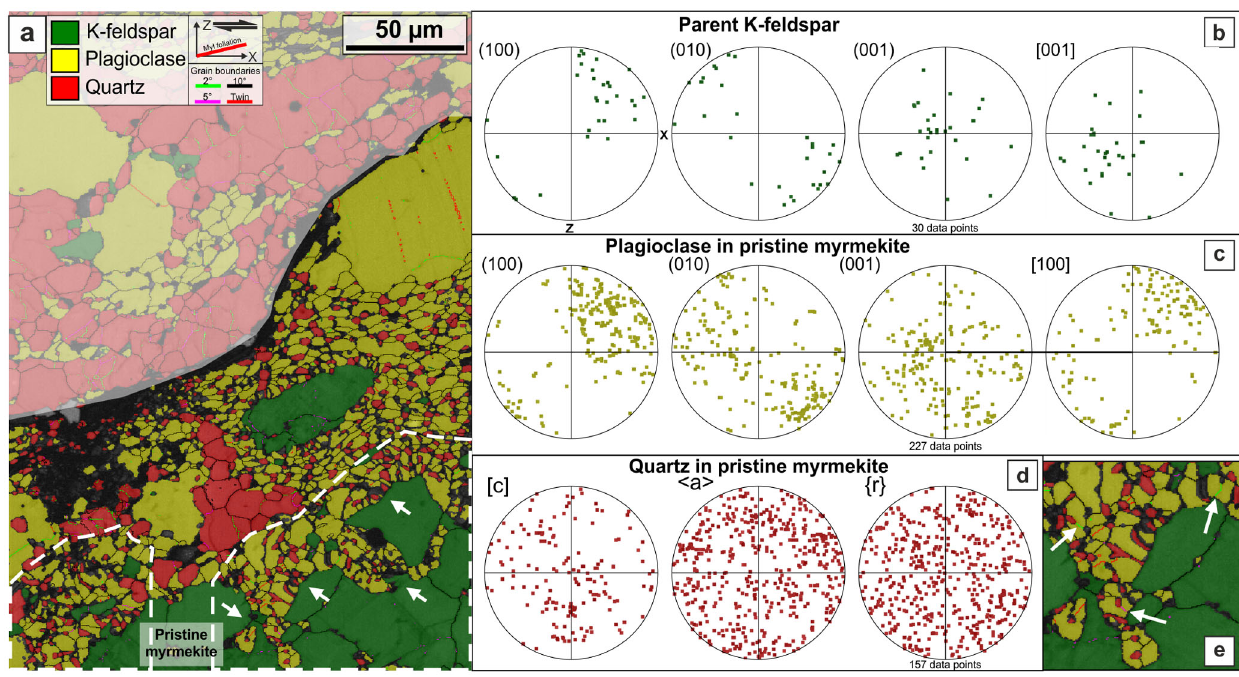
Figure 3. EBSD map and crystallographic orientation data of incipient myrmekite and parent Kfs. (a) EBSD-derived phase map. The area delimited by dashed polygons represents pristine myrmekite. Grain boundaries are colour-coded according to the maximum angle of misorientation observed across them. Pole figures for (b) Kfs grains on which pristine myrmekite nucleated; (c) Plg and (d) Qtz in pristine myrmekite. (e) Enlargement of EBSD map in (a) showing the low-angle (and twin, red) boundaries in plagioclase abutting against quartz vermicules (indicated by white